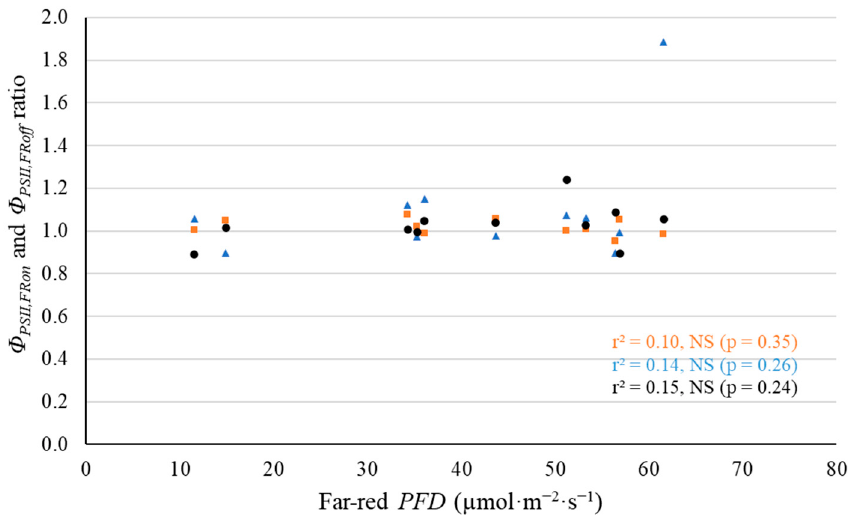
Figure 10. With a background of 204 µmol·m − 2 ·s − 1 white LED light, turning off supplemental far-red lights had no effect on quantum yield of photosystem II for ‘Cherokee’ (orange squares), ‘Green Saladbowl’ (blue triangles) and ‘Little Gem’ (black dots) lettuce 28 days after the start of far-red light treatment. The r 2 and p values for regression of each cultivar are shown with the respective color.